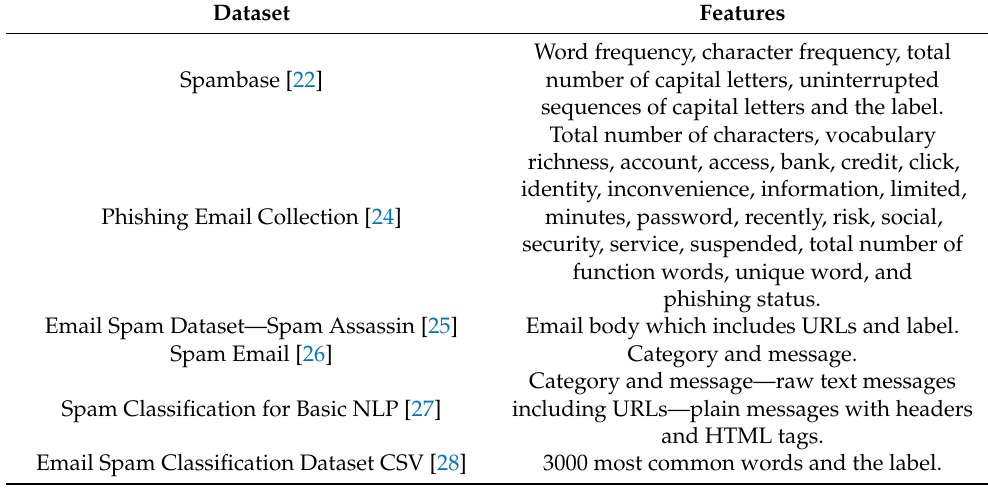
Table 2. Feature